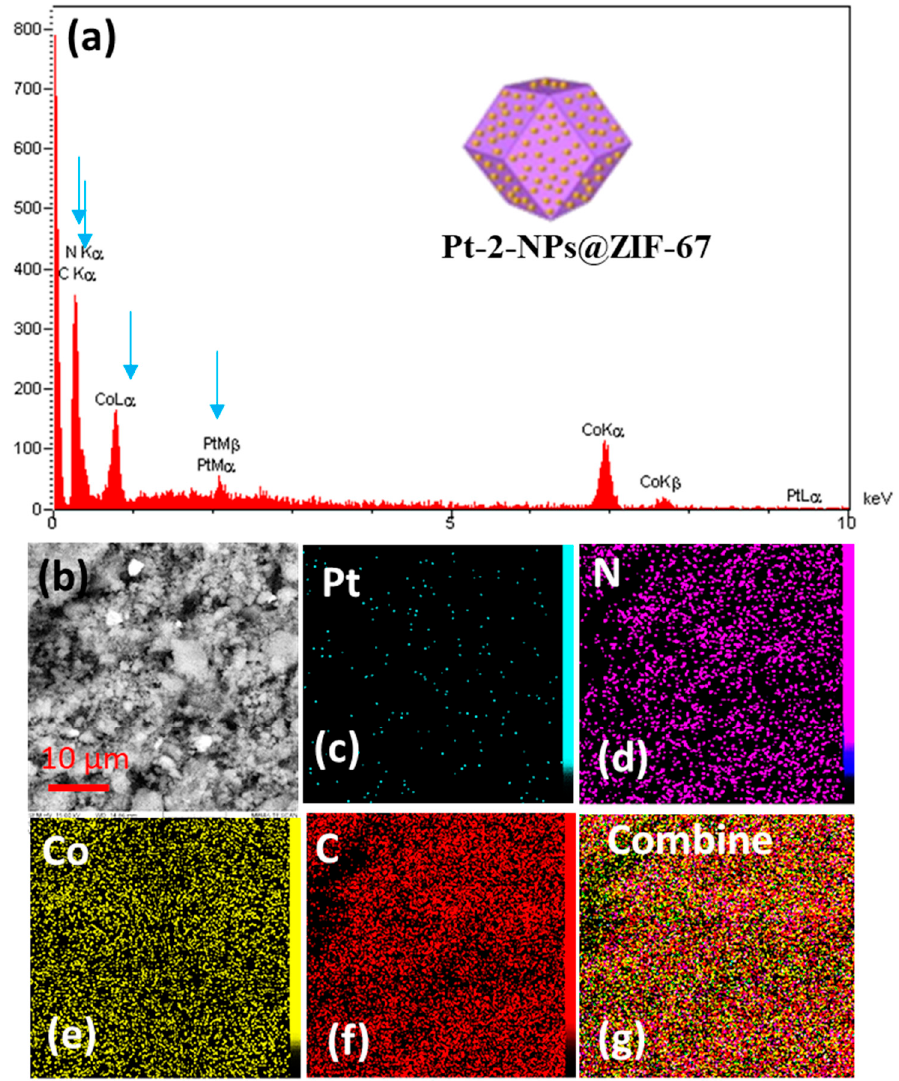
Figure 5. Pt@ZIF-67: ( a ) The SEM-EDS spectra and ( b – g ) SEM-mapping. Table 2. Weight percentage of elements from EDS analysis.